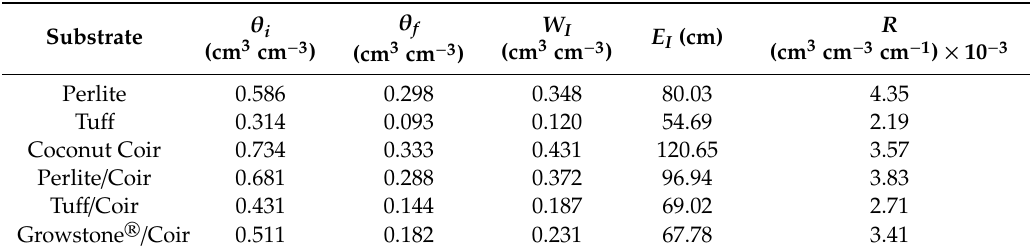
Table4. Integral water storage andenergy values and associated threshold water contents (for parameter definitions see Equations (8) to (10) in Section